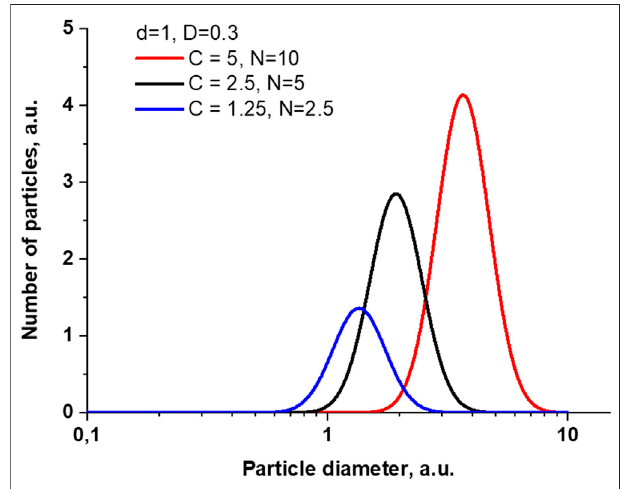
FIGURE 8 | Change in average particle size with time. Data are given for severalvaluesoftheparameterC,whichisproportionaltotheconcentrationof particles.